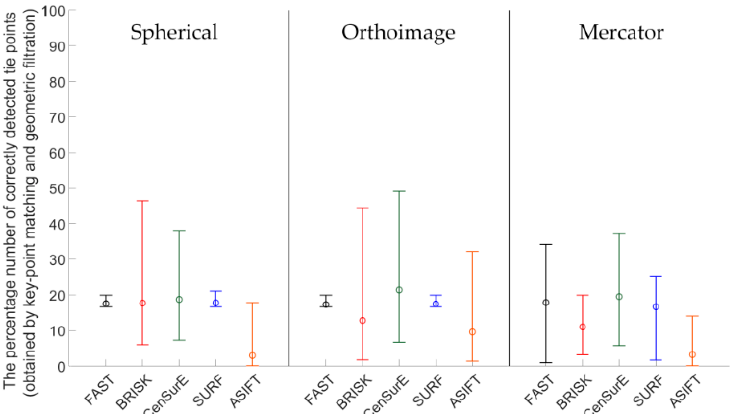
Figure 11. Diagram of the mean (circles), maximum, and minimum percentage of correctly detected and matched key points using blob (ASIFT, SURF, and CenSurE) and point (FAST and BRISK) detectors for rasters in the spherical projection, orthoimages, and the Mercator projection; Test Site III.